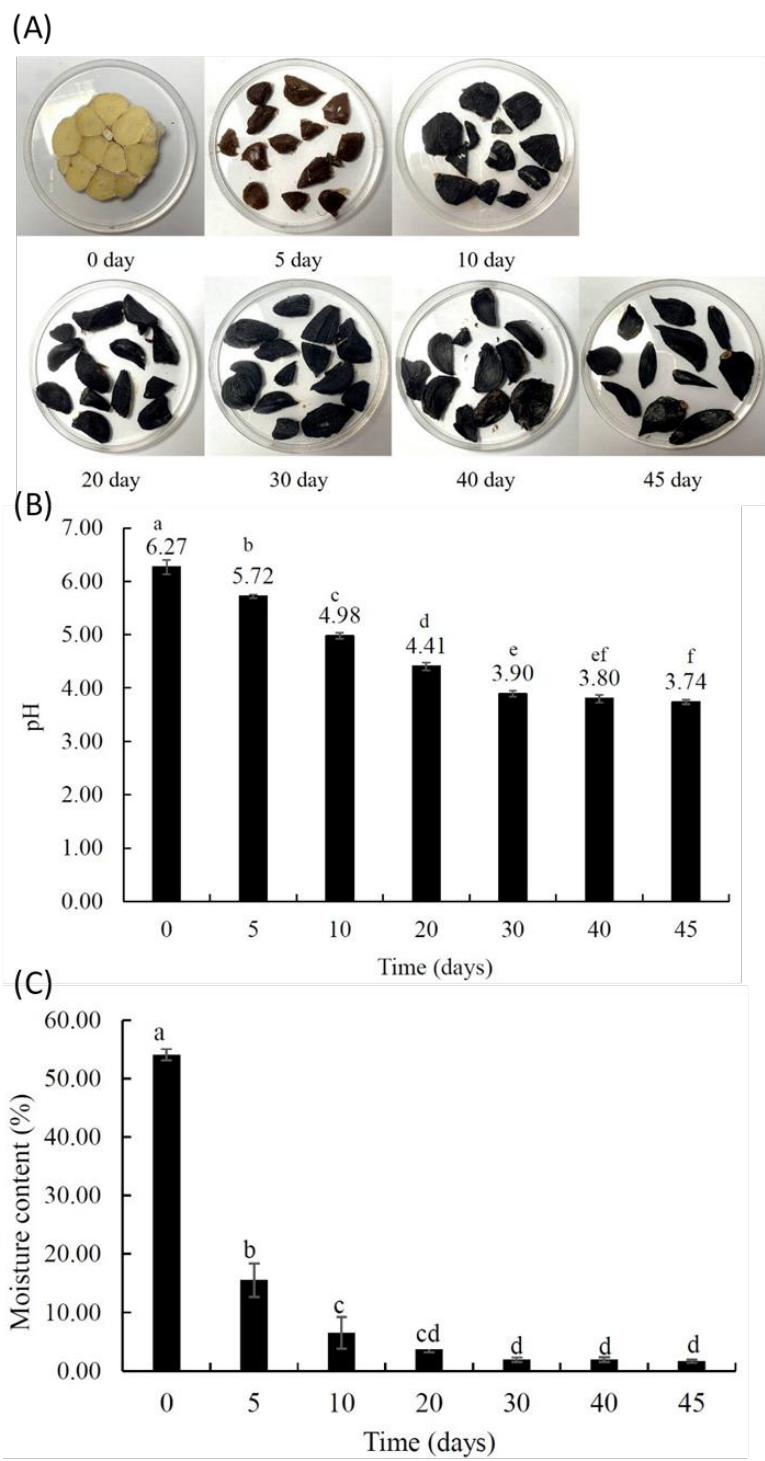
Figure 1. ( A ) The appearance of fresh garlic and black garlic obtained from different aging durations. ( B ) pH value of hot-water extract broth of fresh garlic and black garlic obtained from different aging durations. ( C ) Moisture content of fresh garlic and black garlic obtained from different aging durations. Each value is expressed as mean ± S.D. ( n = 3). Different superscript letters indicate a significant difference ( p < 0.05). Table 1. Extract yield, water activity, and color of fresh garlic (on day 0) and black garlic obtained from different aging days.